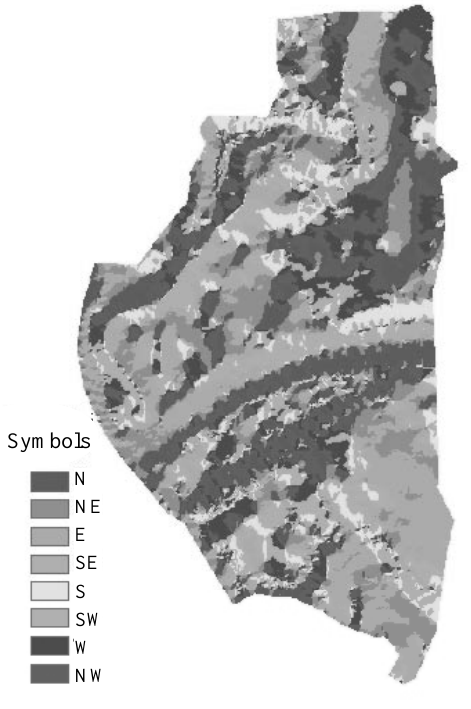
Fig 7. Relief variability map after generalisation Symbols Symbols